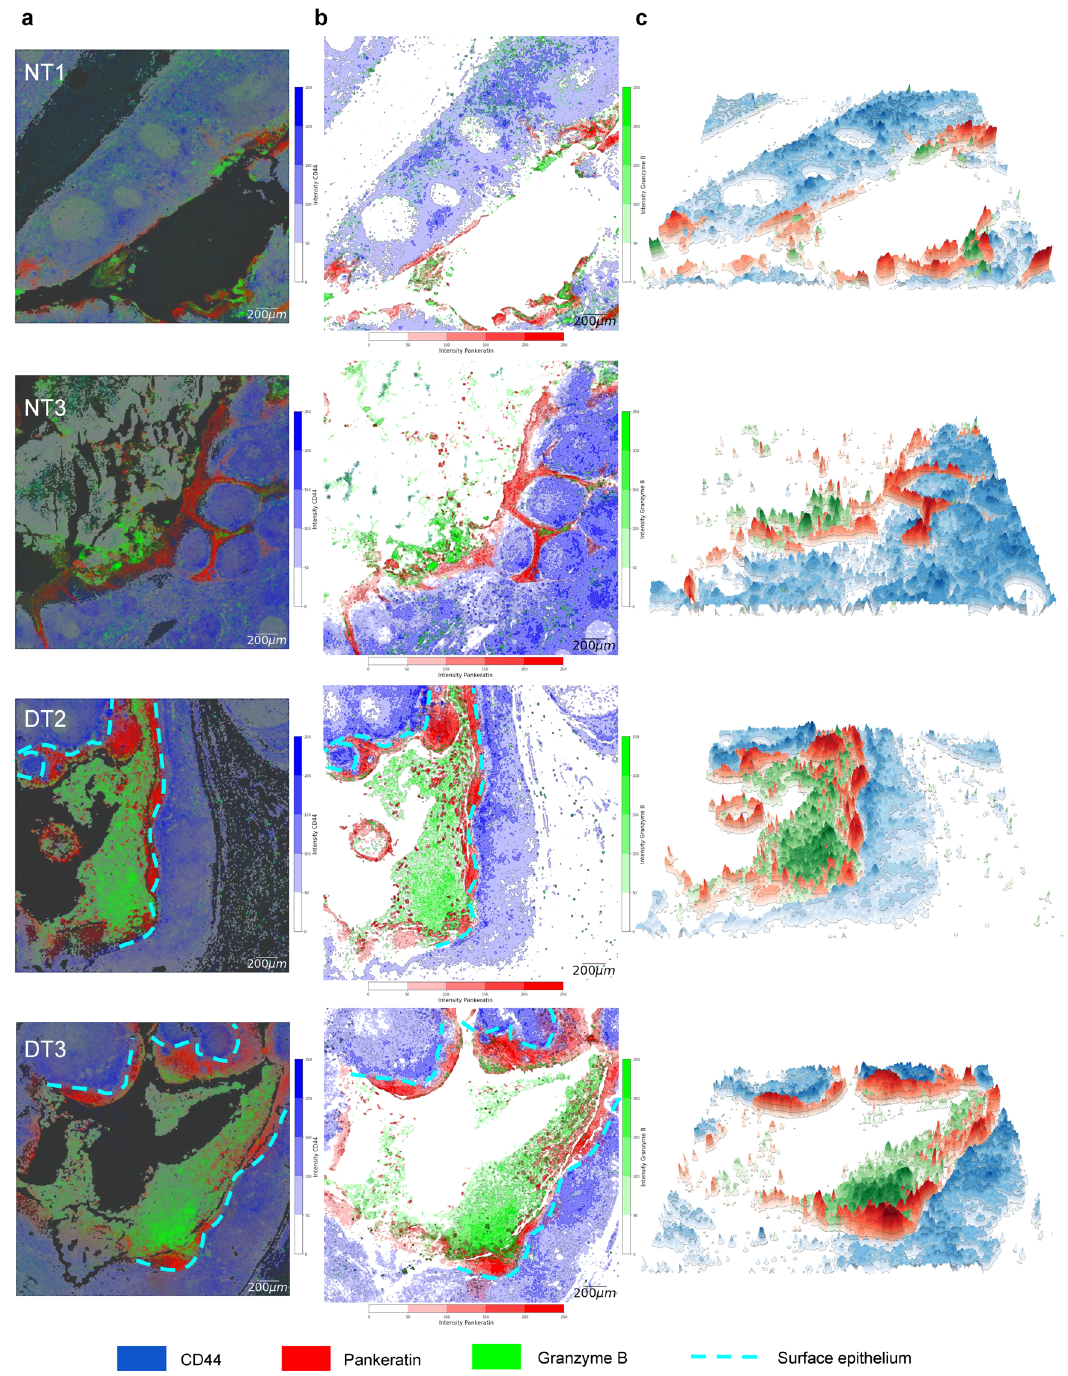
Fig. 7 Spatial topographic map for two-dimensional (2D) and three-dimensional (3D) visualization of CD44, Pankeratin, and Granzyme B layering in diseased and healthy tonsil tissues. a 2D intensity plot of overlaid CD44 (blue), Pankeratin (red), Granzyme B (green) markers is shown. The scale bar is 200 µ m. b 2D topography plot of density maps of markers in the form of contours is presented. The light blue dashed lines denoted the surface epithelial boundary and the crypt region in the disease tonsil. The scale bar is 200 µ m. c 3D topography plot of the same three markers is shown. Distinct 3D areas with high CD44 and Pankeratin expressions were layered concerning each other ’ s spatial distribution in diseased tonsils, whereas CD44 enrichment was more randomly distributed in normal tonsils. The scale bar is 200 µ Methods based on various multiplexed marker expressions and their Tonsil tissue preparation and isotope-conjugated antibody labeling . Normal dominant spatial enrichments in distinct tissue regions, providing tonsil and diseased formalin- fi xed paraf fi n-embedded (FFPE) blocks were pur- the hierarchy of single-cell to anatomy relationships in cancer chased from a third-party vendor (Biomax US with tissue IDs 1052993.7 and biopsies. With the addition of patient information, disease stage, 1051869.3). The FFPE tissue blocks were then cut into serial sections at a thickness and type, SpatialViz can design more personalized treatments of 5-µm and mounted on Superfrost ™ Plus Gold Slides (Catalog number: using complementary deep learning-based analysis pipelines. FT4981GLPLUS, ThermoFisher). Three serial tissue slices from each condition